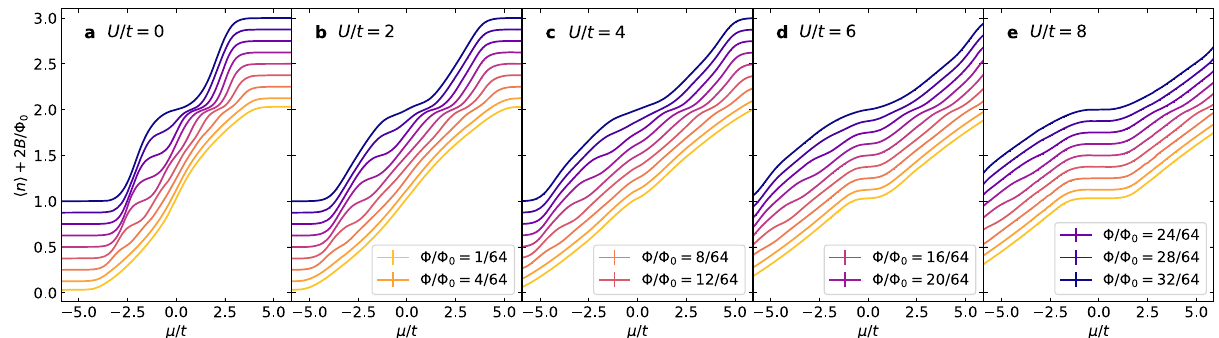
Fig. 1 Electron density vs. chemical potential. Electron density 〈 n 〉 vs. chemical potential μ a in the non-interacting system, and b – e with Hubbard U / t = 2 – 8. Curves with the same color have the same magnetic fi eld strength Φ / Φ improve visibility of in fl ection points. Error bars, corresponding to ±1 standard error of the mean, estimated by jackknife resampling, are smaller than the size of data points. All plots have inverse temperature β = 4/ t